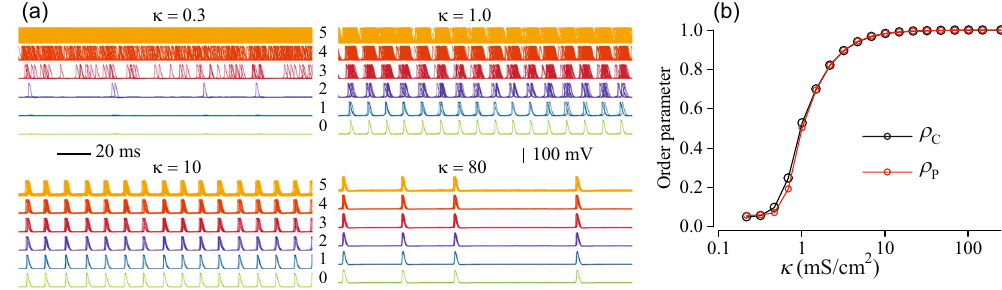
Figure 3. Synchronization of APs firing in a tree with G = 5 generations and d = 3 branching in the excitable regime. Peripheral nodes were excited by the external currents (4) with parameters I = 20 μ A /cm 2 and D = 500 ( μ A/cm 2 ) 2 ms. ( a ): Voltage traces of the HH nodes. Each sub-panel shows 200 ms long superimposed voltage traces of nodes within a generation g , g = 1, … , 5, for the indicated coupling strength, κ (mS/cm 2 ). Horizontal axis is time. Numbers next to voltage traces indicate generations within the tree, g = 0 corresponds to the central node and g = 5 corresponds to the peripheral generation, respectively. ( b ): Kuramoto order parameters of the network vs the coupling strength; ρ P is calculated for the peripheral nodes only; ρ C is calculated for all